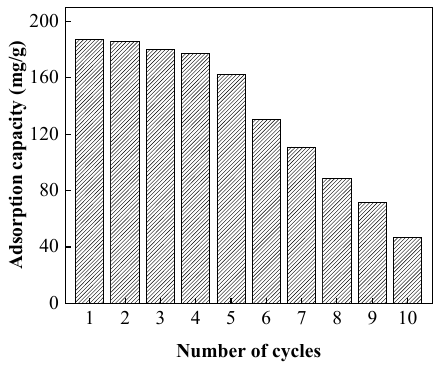
ff ect of regeneration cycles on the RB5 adsorption capacity of Ct-PAC-HDA Figure 8. Effect of regeneration cycles on the RB5 adsorption capacity of Ct-PAC-HDA beads. Figure 8. E